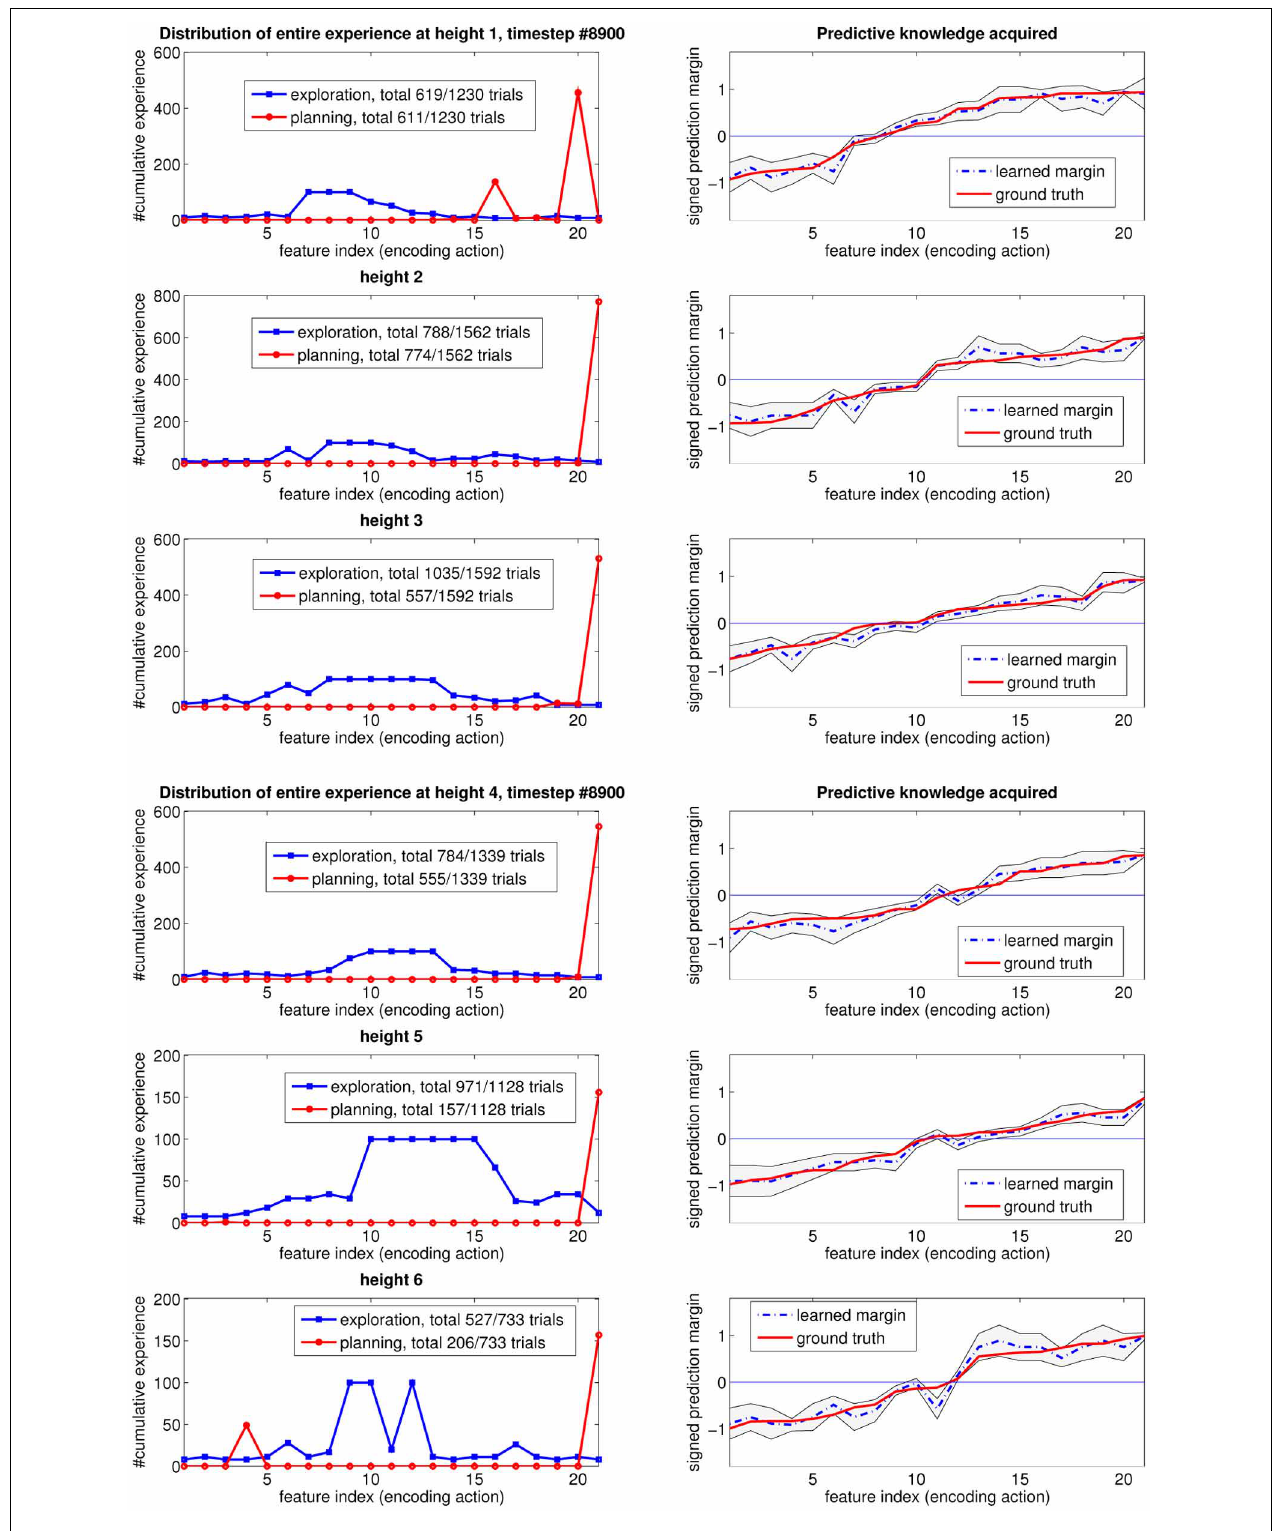
FIGURE 8 | Experience distribution after the last timestep (learning has completed) for heights 1–6.